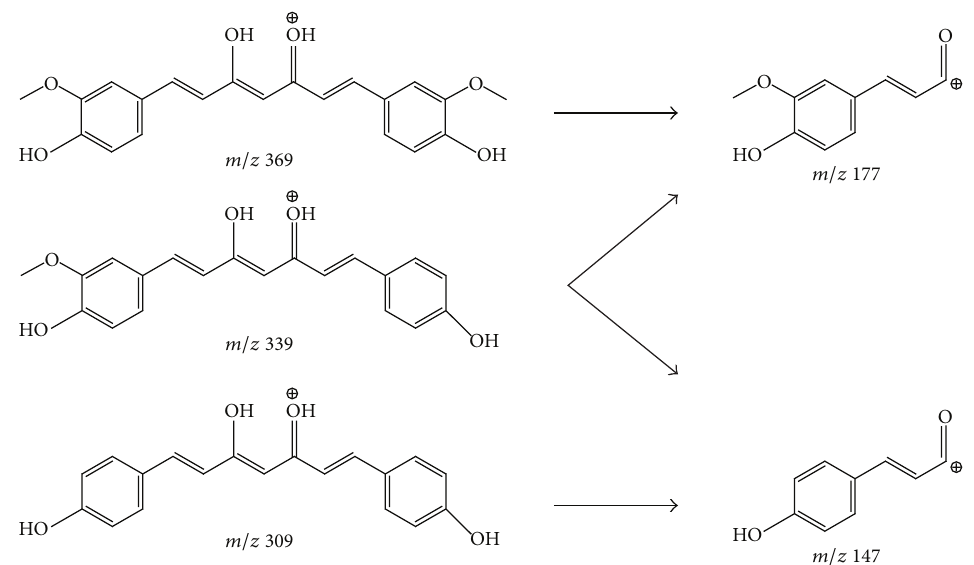
Scheme 3: Fragmentation pathway of curcuminoids (positive